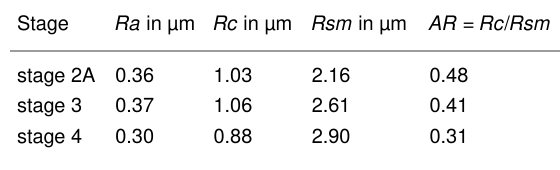
Table 1: Mean values of roughness parameters of cuticular ridges on leaf surfaces of Schismatoglottis calyptrata at stages 2A, 3, and 4.